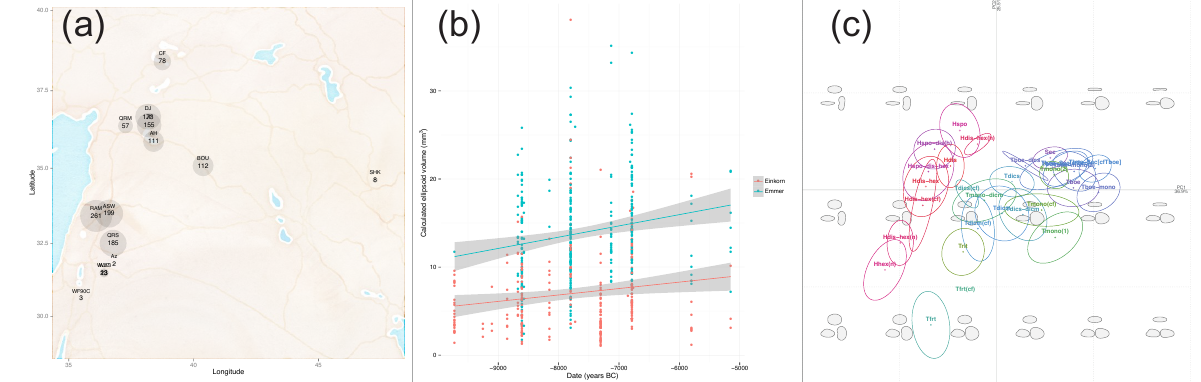
Figure 1. (a) Map of the archaeological sites along with their sample sizes. (b) The increasing trend for the grain volume observed in emmer and einkorn grains. The regression indicates a 50% increase in the grain volume over 5000 years. (c) The first two axes of the principal component analysis ( ∼ 70% of the total variance) along with confidence ellipses labelled with taxon names and, in the background, a morphospace of the reconstructed shapes with the three views arranged as dorsal above, lateral left and polar right. The red ensemble on the left gathers all Hordeum taxa; the blue/green ellipses are all Triticum